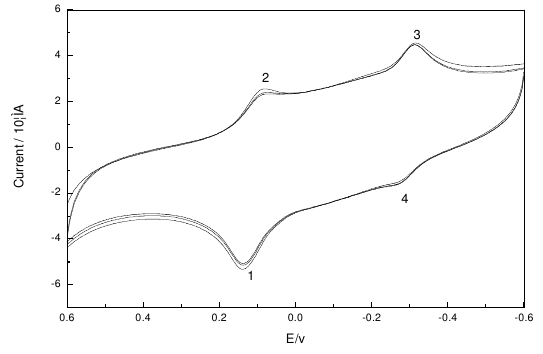
Figure 3. Repeated cyclic votammograms (6 scans) of 1.0×10 -4 mol/L DA in PBS of PH 7.4 at the poly (acridine red) film modified electrode. Sensitivity: 1.0×10 -4 A/V. Scan rate: 100